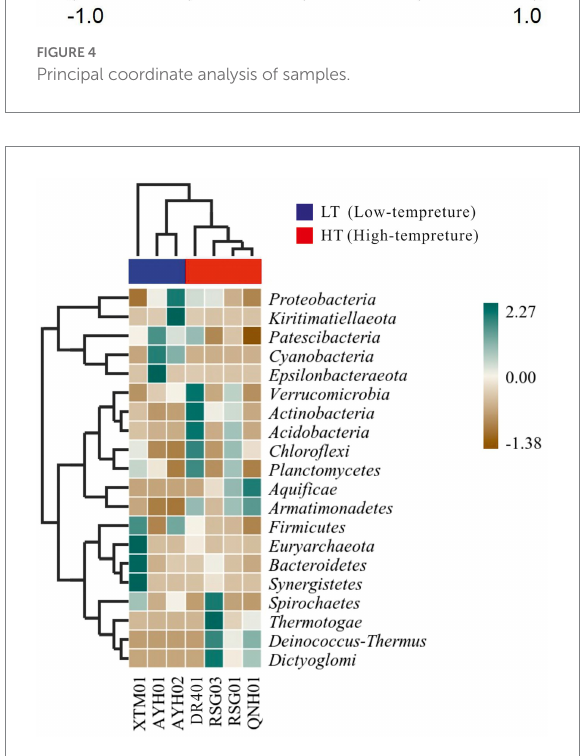
FIGURE 5 Heatmap of the bacterial phylum in hot springs on the Northeast Tibetan